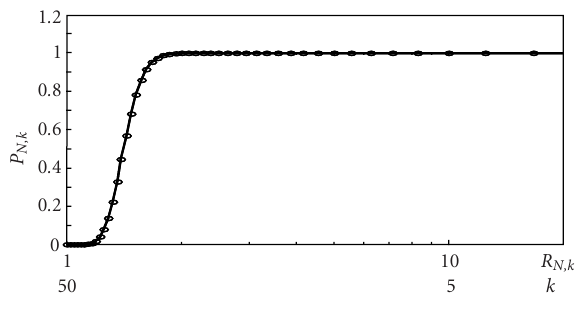
Figure 3: Example of P N , k versus R N , k characteristic with N = 50 and p = 0 .